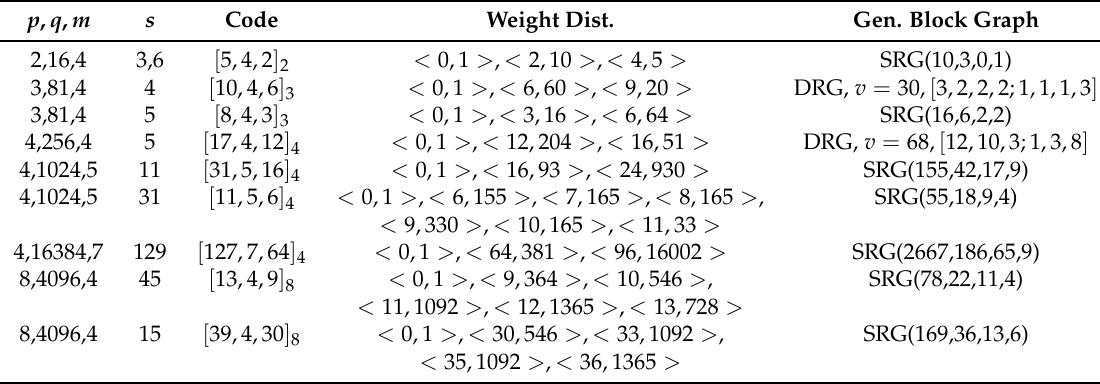
Table 10. Generalized block